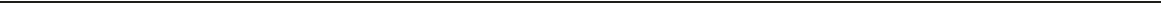
Fig. 5 Binding of p52/ETS1 heterotetramer to the − 146C>T mutant TERT promoter. a A ribbon diagram showing a p52/ETS1 heterotetramer bound to − 146C>T TERT promoter DNA observed in the crystal lattice. The regions of p52 that heterodimerize with ETS1 and homodimerize with itself are indicated. b Color-coded domain architecture of mouse GABPB and a model of GABP heterotetramer (PDB code of the crystal structure showed here: 1AWC). LZD leucine zipper-like domain. c − 146C>T mutation-generated and the tandem fl anking native ETS motifs in the core TERT promoter. d The effect of mutation of adjacent ETS motifs ( − 93T>A, − 97C>A, − 192T>A) on the activation of mutant TERT promoter. Western blot analyses were performed in parallel to assess the levels of p100/p52 and ETS1 in luciferase reporter assay cells, with actin as a loading control. e The effect of mutation of adjacent ETS